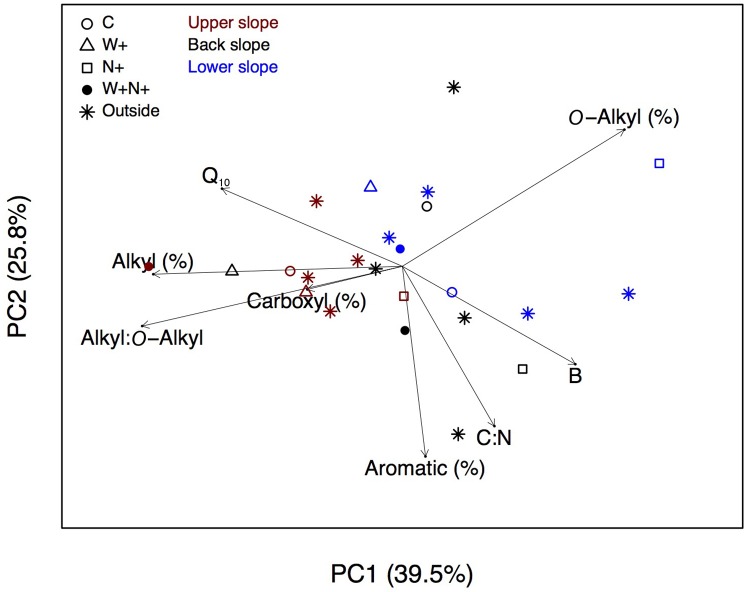
Principal component analysis (PCA).Projection of eight soil variables (Q10, B, C:N and alkyl:O-alkyl C ratios, and percentages of alkyl, O-alkyl, carboxyl and aromatic compounds), and sample scores for inside and outside experimental plots (n = 24) along the two first axes of a PCA. Red, black and blue symbols show upper, back and lower slope positions, respectively.